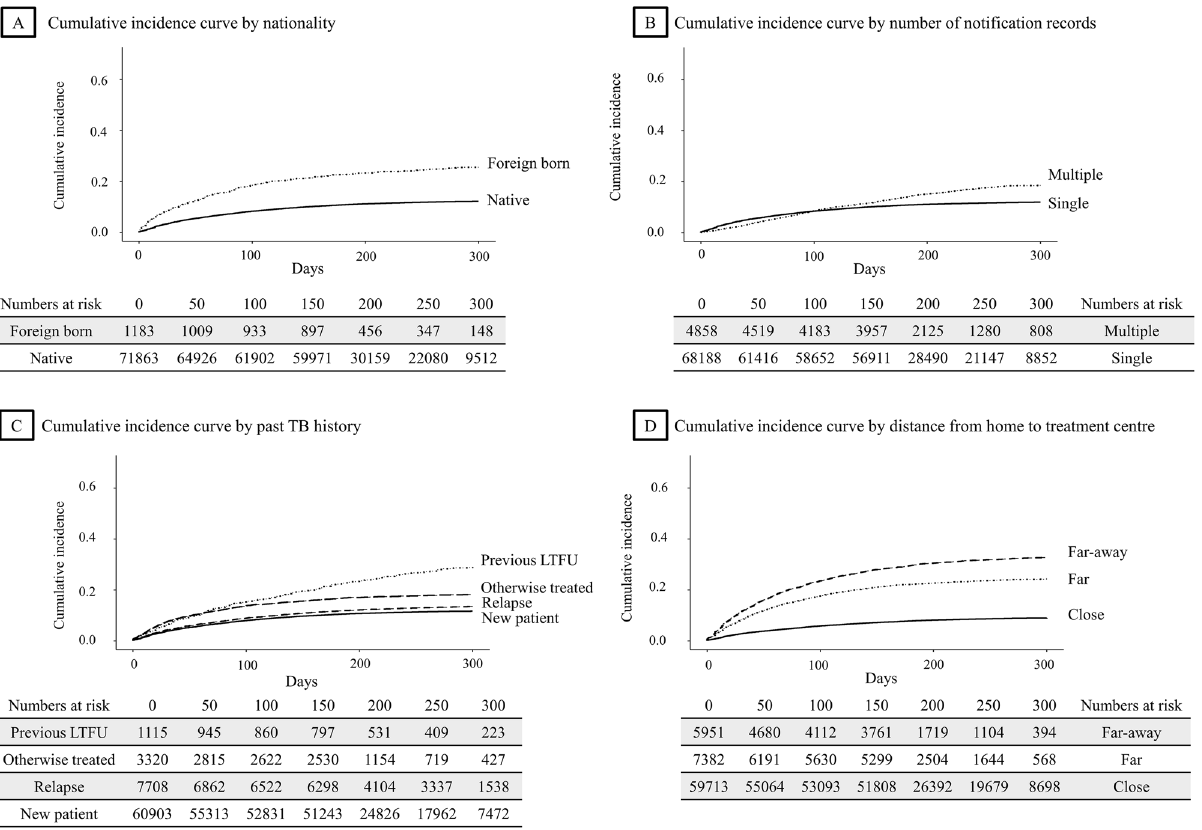
Figure 2. Cumulative incidence curve by nationality, number of notification records, past tuberculosis history and distance from home to treatment centre. LTFU loss to follow-up, TB tuberculosis. Among the type of past TB history, ‘otherwise treated’ denoted that ‘treatment after failure patients’ and ‘other previously treated patients’ whose outcome of previous treatment was unknown or undocumented. The distance ‘close’ applied to cases where the treatment centre and patient’s residence were within the same municipal level divisions (district, city, or county). ‘Far’ applied to cases where the treatment centre was in the different district, city or county but located within the same large administrative divisions (province or metropolitan city). ‘Far-away’ applied to cases where the treatment centre was located within the different large administrative divisions.